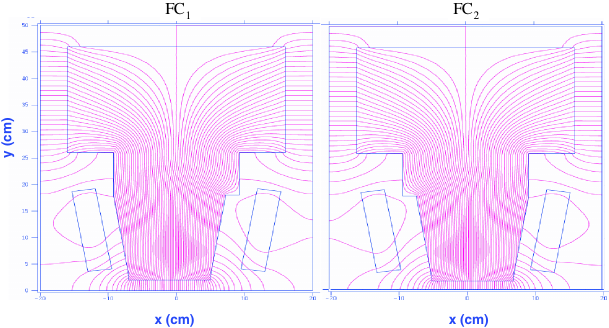
FIG. 10. (Color) Sketch in the z - x plane of the poles cut sym- metrically with respect to the average beam trajectory for FC , FC , 1 3 ( FC and FC ) and for FC ( FC , HC , and HC ). The shape of 3 5 2 4 1 2 , FC , HC , and HC ) x . 2 4 1 2 the poles without any modification is also indicated (dashed line). Dimensions are in cm.